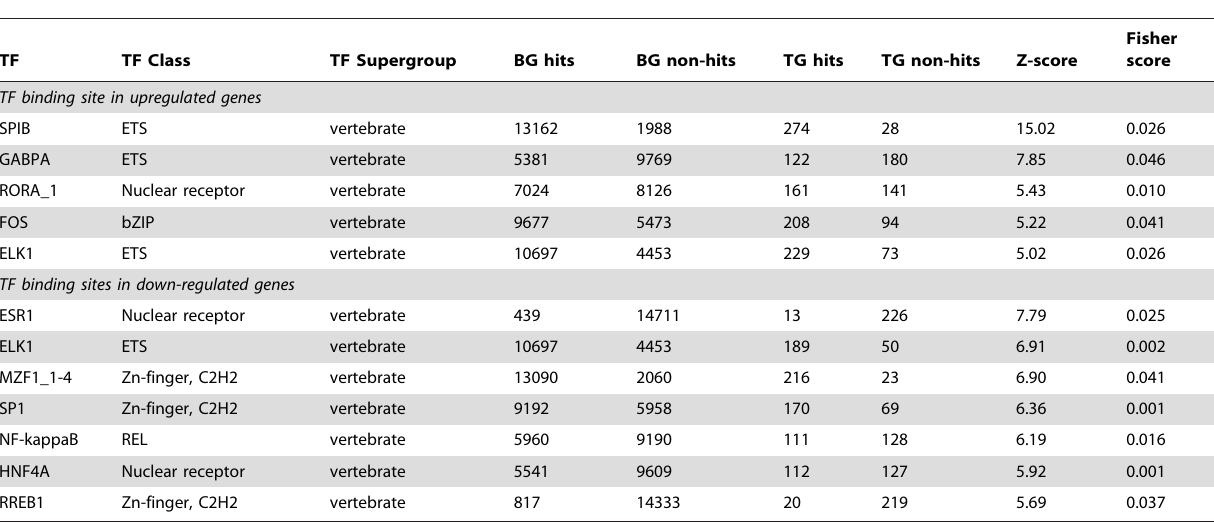
Table 5. Enrichment of transcription factor binding sites in the differentially expressed